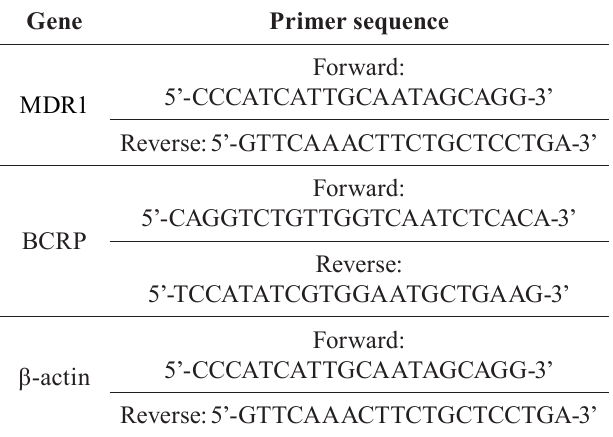
TABLE I - P rimers used in reverse transcription-quantitative polymerase chain reaction Gene